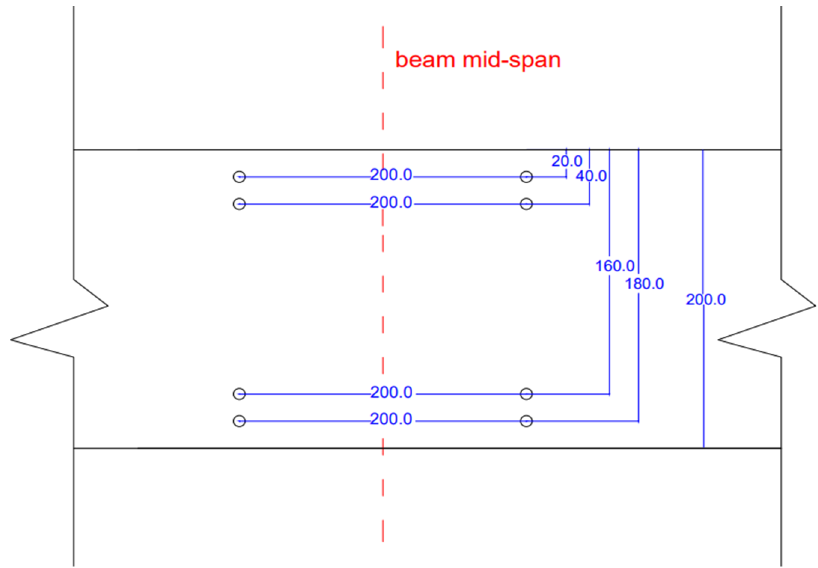
Figure 14. Distribution of demec points on the beam in the tension and compression faces.